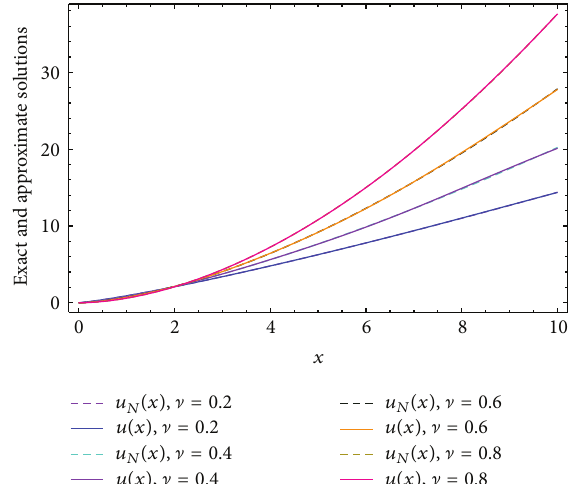
Figure 14: Comparing the exact and approximate solutions at 𝑁 = 12 , 𝛼 = 0 , 𝛽 = 1 , and ] = 0.2 , 0.4, 0.6, and 0.8.